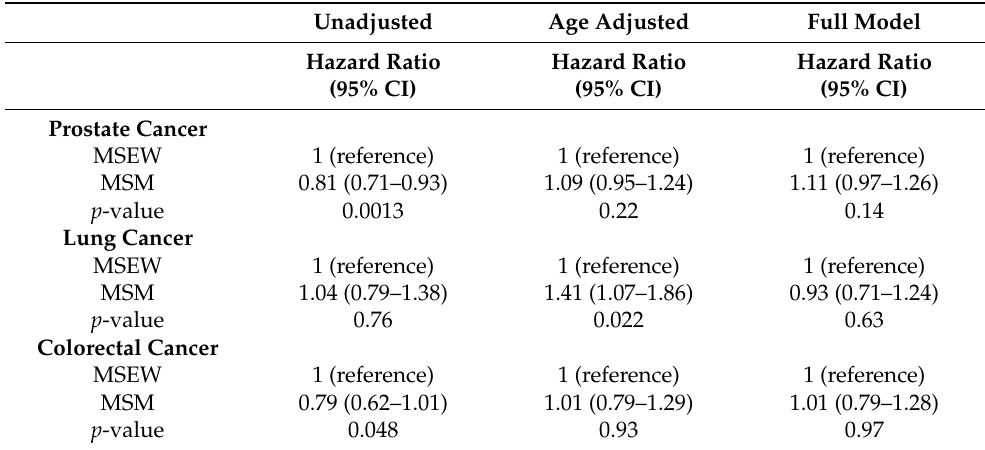
Table A6. Models of prostate, lung, and colorectal cancer in